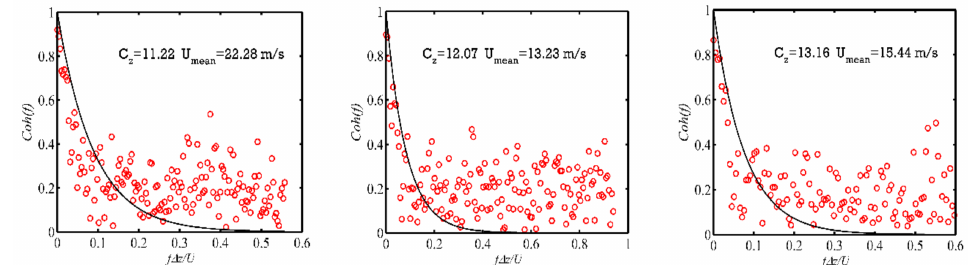
Figure 28. Coherence function at different wind speeds in the v direction.